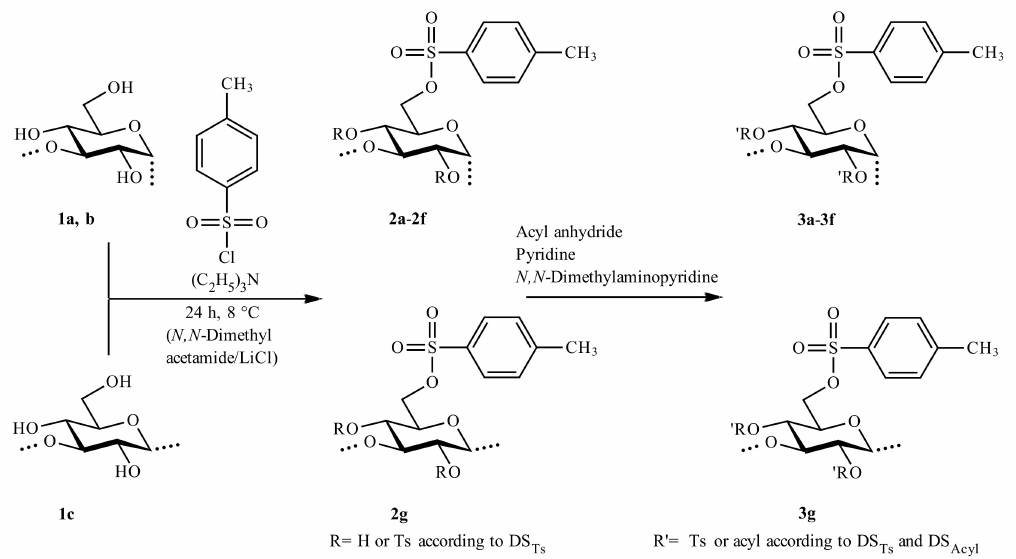
Figure 1. Synthesis of 1,3-glucan p -toluenesulfonic (Ts) acid esters by conversion of the biopolymer dissolved in N , N -dimethyl acetamide / LiCl with p -toluenesulfonic acid chloride and triethylamine was followed by peracylation (degree of substitution of tosyl groups, DS Ts , of acyl groups, DS Acyl